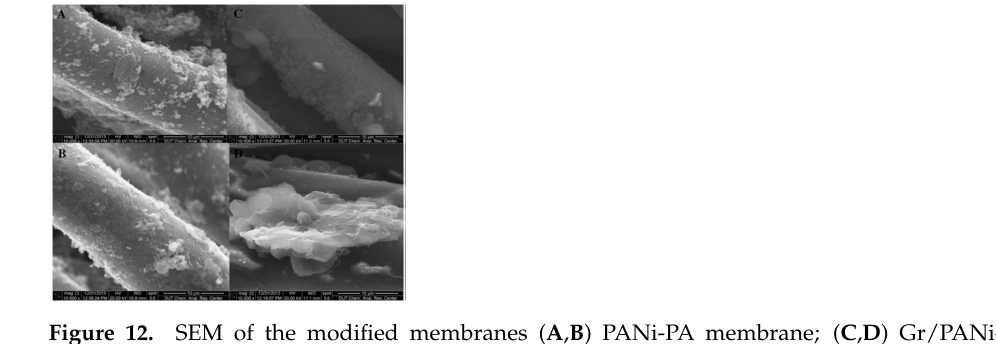
Figure 12. SEM of the modified membranes ( A , B ) PANi-PA membrane; ( C , D ) Gr/PANi-PA membrane) after use in EMBR. ( A , C ) × 10,000, ( B , D ) × 10,000. Provided with permission from Elsevier